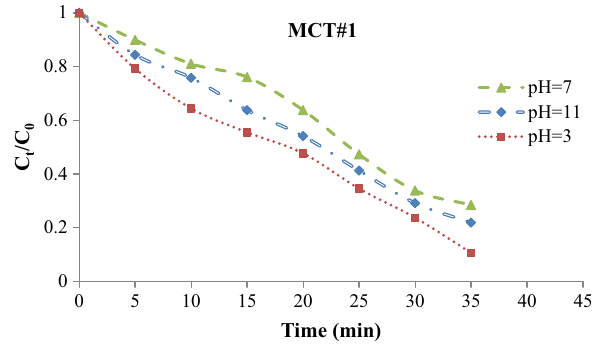
Fig. 4 Changes in MO destruction with irradiation time and pH in the suspension containing MCT#1 as photocatalyst